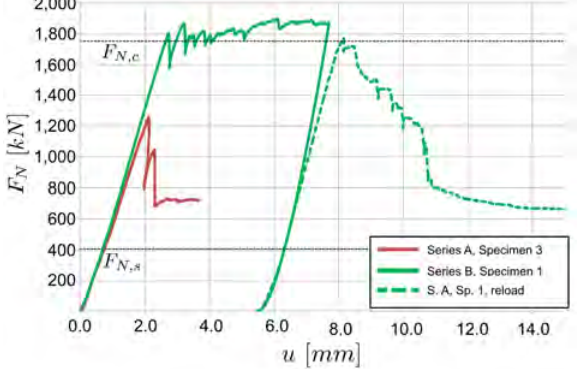
Figure 5. Force–distance diagrams, two selected